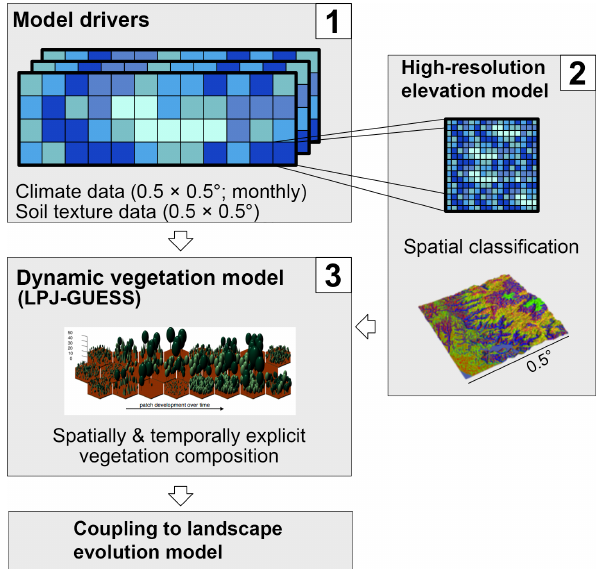
Figure 2. Schematic procedure of simulations. Coarse resolution model driving data (1) is disaggregated using a high-resolution elevation model and topographic landform classification (2), and the ecosystem model LPJ-GUESS then simulates vegetation state and dynamics using the landform classification to simulated topographic-adjusted patch composition (3). Vegetation cover and surface runoff results can then be passed on to a coupled landscape evolution model (LEM) (not implemented in this study, see Schmid et al. (2018) for a description of the